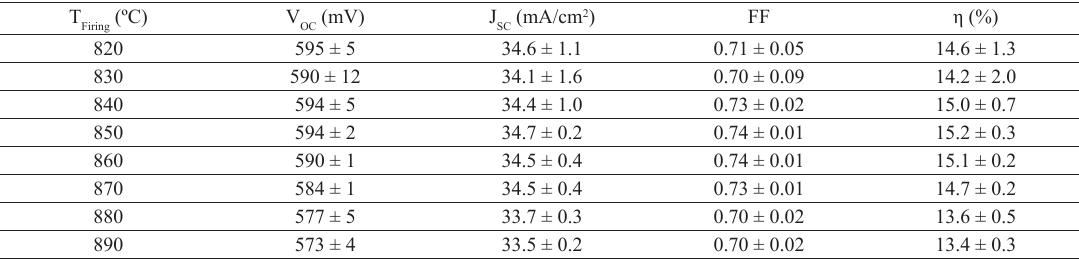
), short-circuit current density (J OC ). Firing